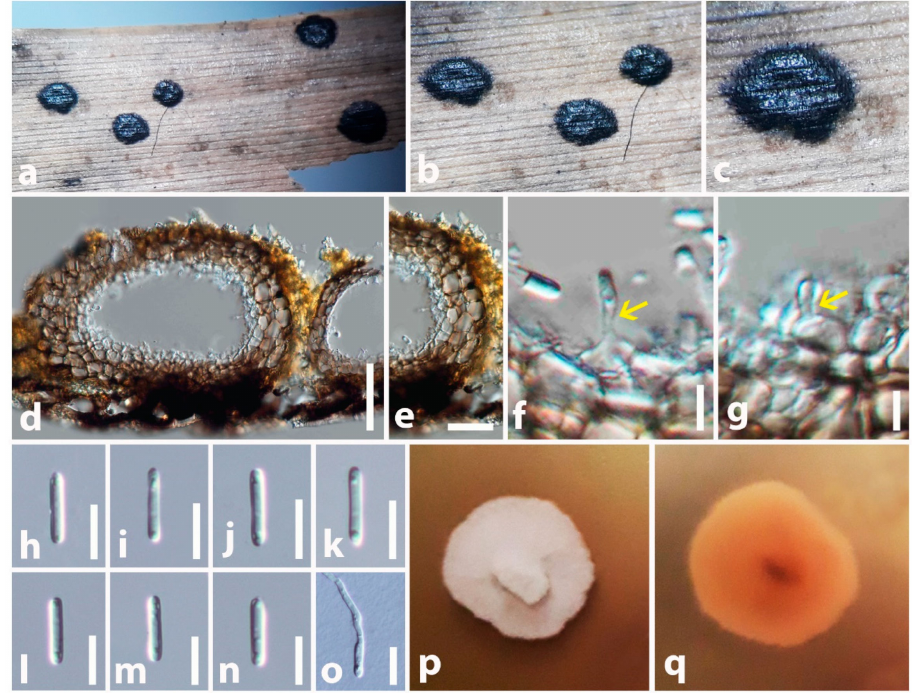
Figure 6. Pseudocoleophoma zingiberacearum (CMUB 39984, new host record ). ( a , b ) Conidiomata on dead leaf of Hedychium spicatum . ( c ) Close-up of conidioma. ( d ) Vertical section through conidioma ( e ) Conidioma wall. ( f , g ) Conidiogenous cells with developing conidia (yellow arrows show the conidiogenous cells). ( h – n ) Conidia. ( o ) A germinating conidium. ( p ) Colonies from above (on PDA/4 weeks). ( q ) Colonies from below (on PDA/4 weeks). Scale bars: ( d ) = 50 µ m, ( e ) = 12 µ m, ( f , g ) = 3 µ m, and ( h – o ) = 10 µ